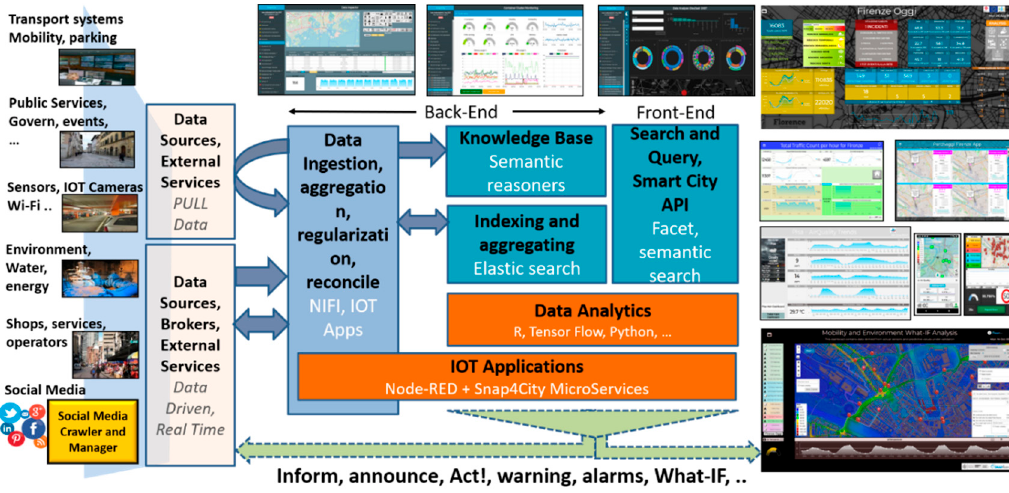
Figure 1. Overview of Snap4City Functional Architecture.